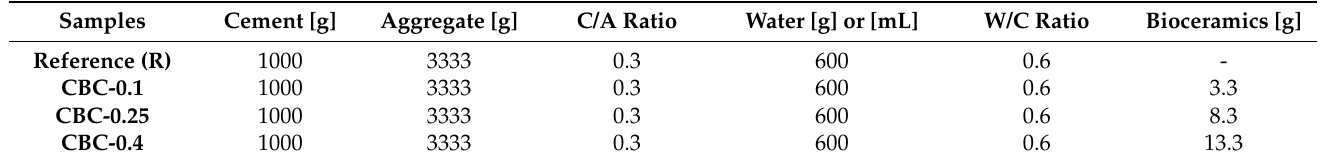
Table 5. Cement mortars composition (per kilogram of white cement